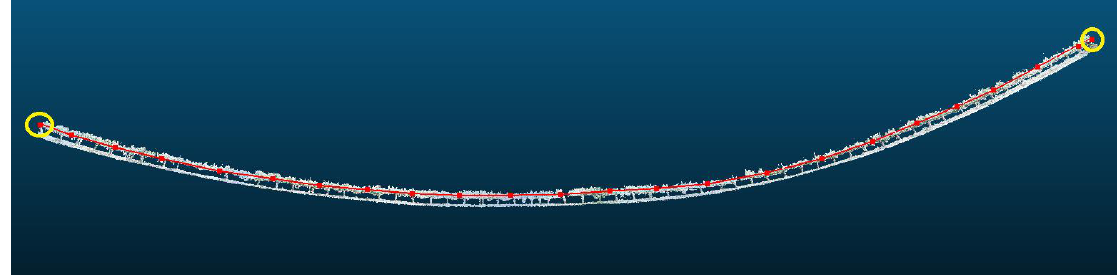
Figure 5. Yellow circles represent the endpoints of the tree row added to the model line of Figure 4.